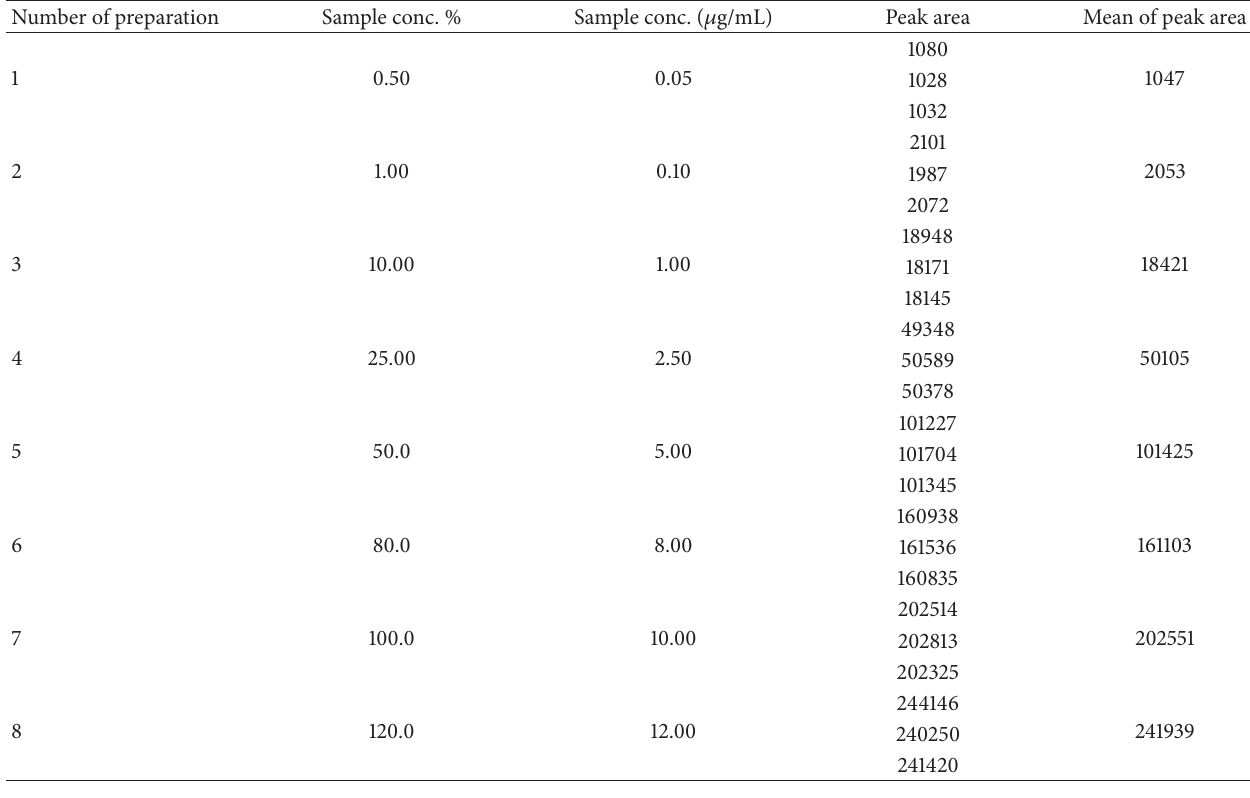
Table 2: Linearity of the method.